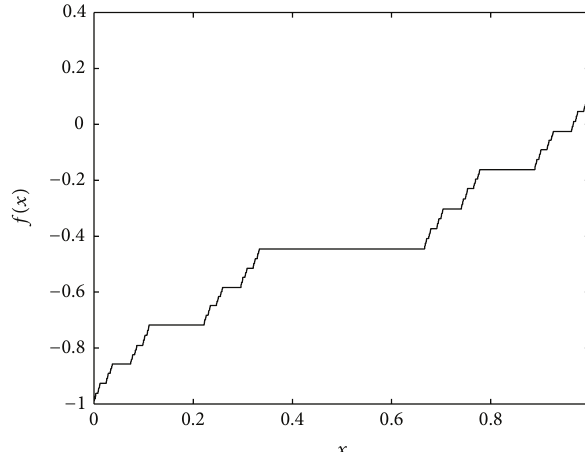
Figure 1: The plot of nondifferentiable solution of (41) with the parameter 𝛼 = ln 2/ ln 3 .